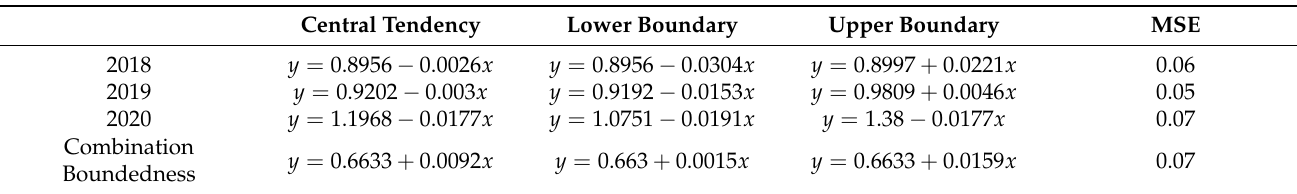
Table 4. Fuzzy linear regression functions with